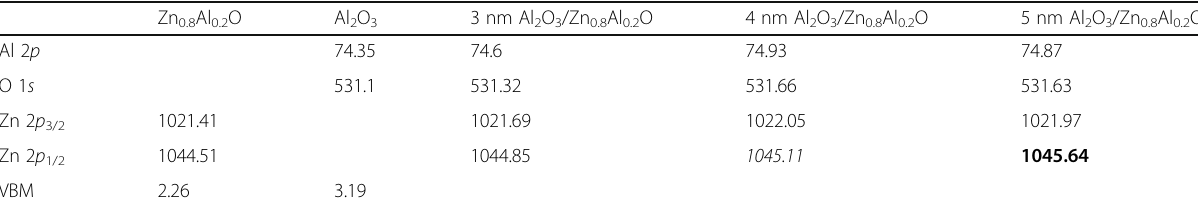
Table 2 Peak positions of CLs and VBM positions used to calculate the Δ E V of the Al 2 O 3 /Zn 0.8 Al 0.2 O